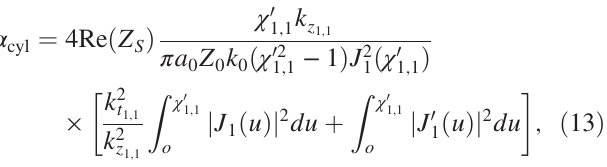
FIG. 8. Cylindrical waveguide: relative attenuation of the first mode on the slab for different coating thicknesses with σ 3 . 5 × 10 5 S/m. Comparison between analytical formulas (dashed line) and CST frequency domain simulations (full